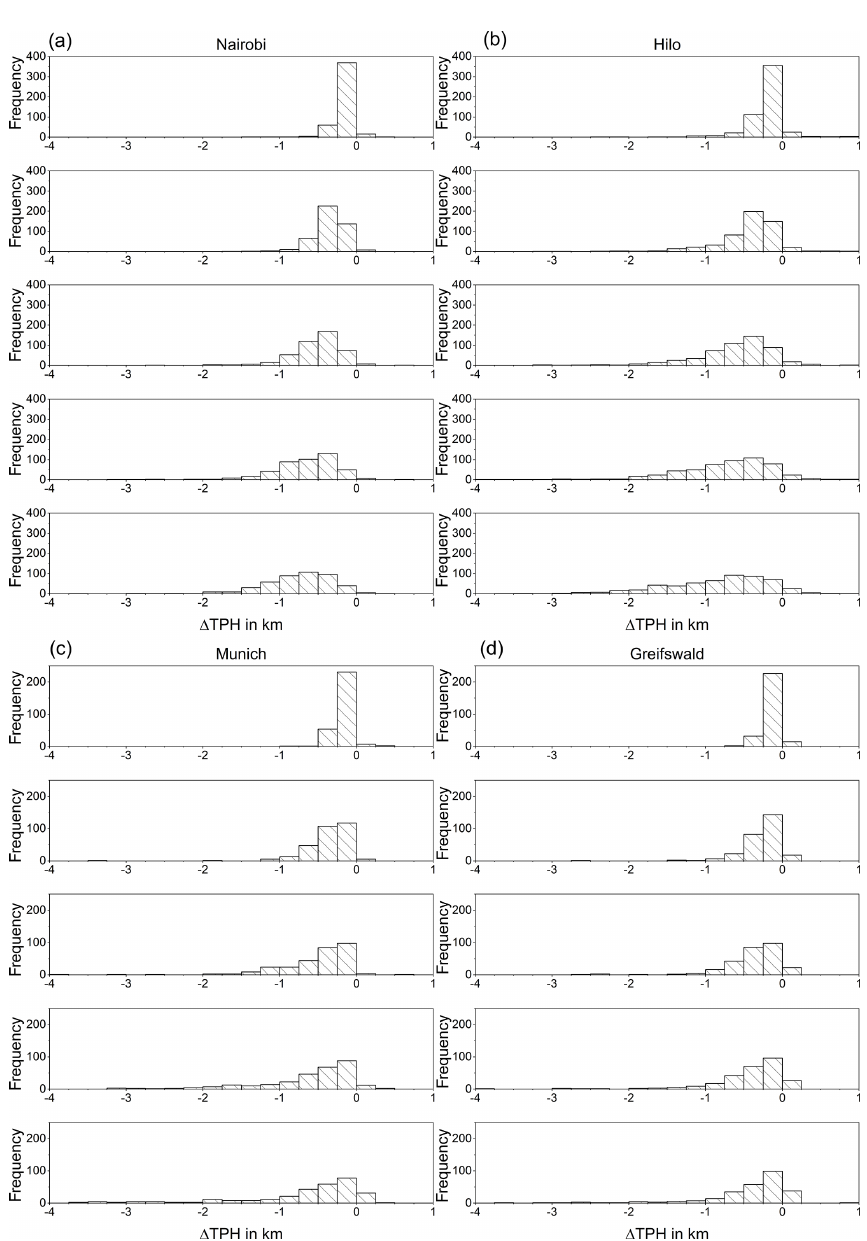
Figure 6. Histograms of tropopause height (TPH) offsets of degraded temperature profiles (Gaussian kernel) with resolutions of 1 to 5km in steps of 1km (from top to bottom) for Nairobi (a) , Hilo (b) , Munich (c) , and Greifswald (d)